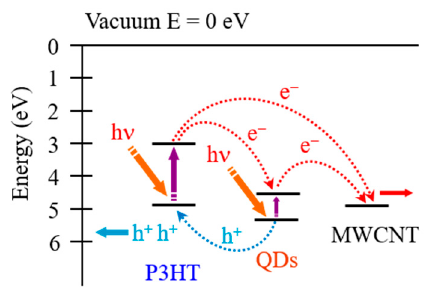
Figure 5. Schematic diagram of the separation and transfer of photoinduced charge carriers in the PbS 1 − x Se x -QD@MWCNT/P3HT nanocomposite. The work function of MWCNTs was referred to [49],